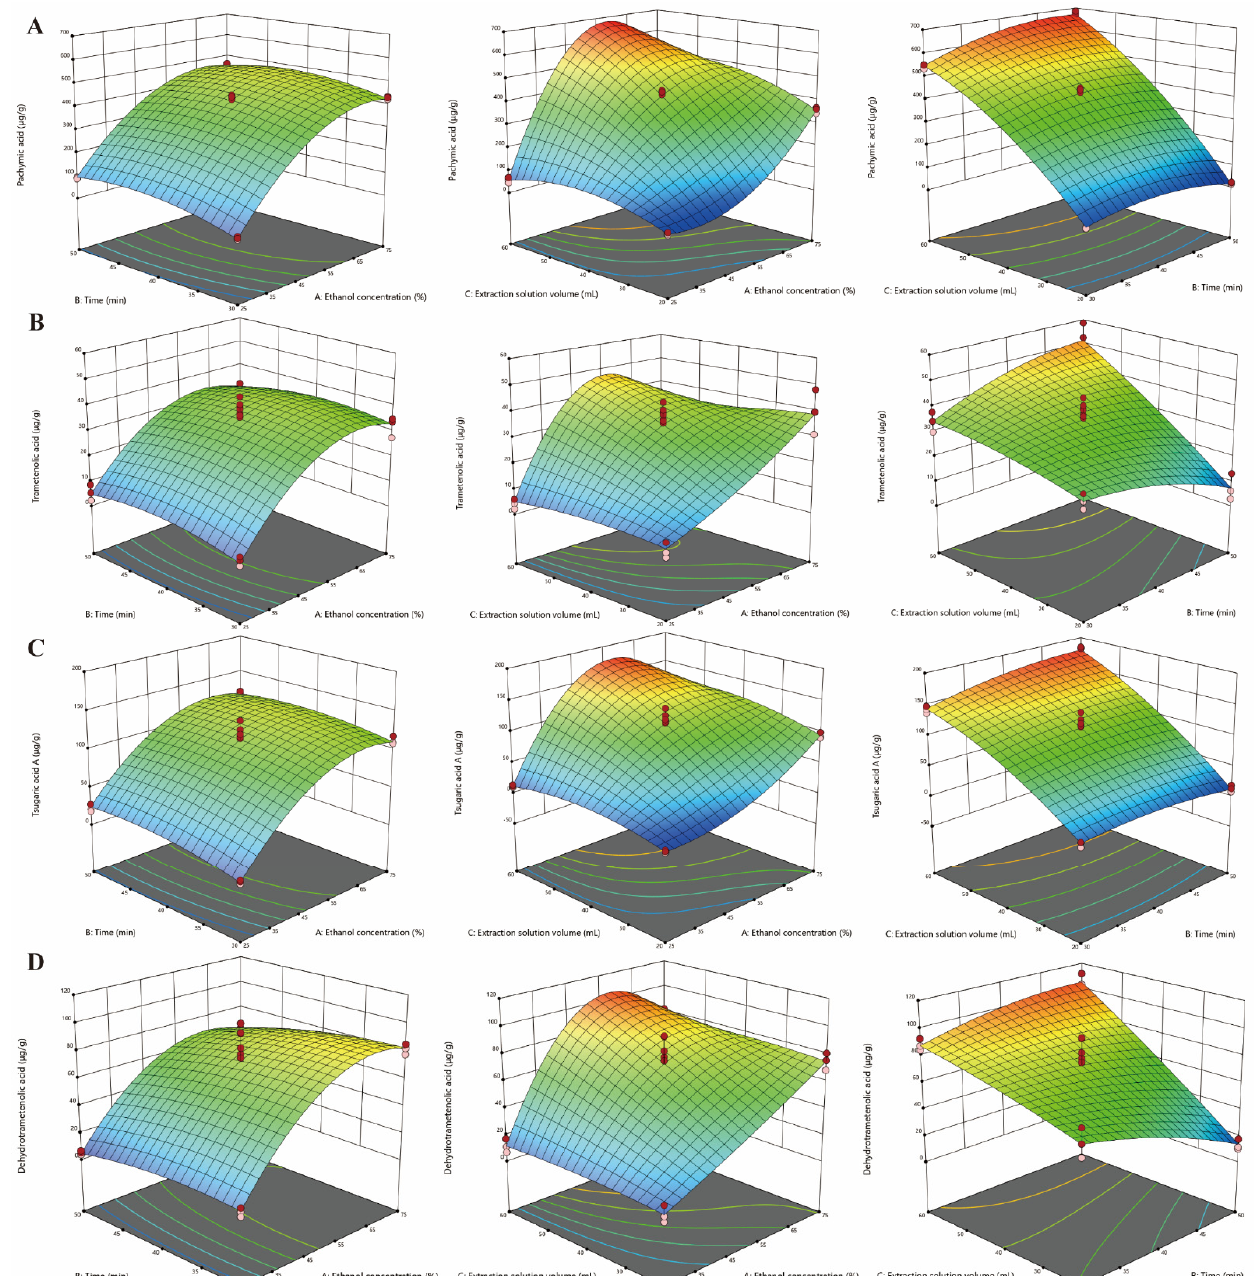
Figure 1. Response surface plots of ultrasound-assisted extraction conditions displaying the influence of independent variables: ( A ) pachymic acid (PA), ( B ) trametenolic acid (TA), ( C ) tsugaric acid A (TAA), ( D ) dehydrotrametenolic acid (DA).